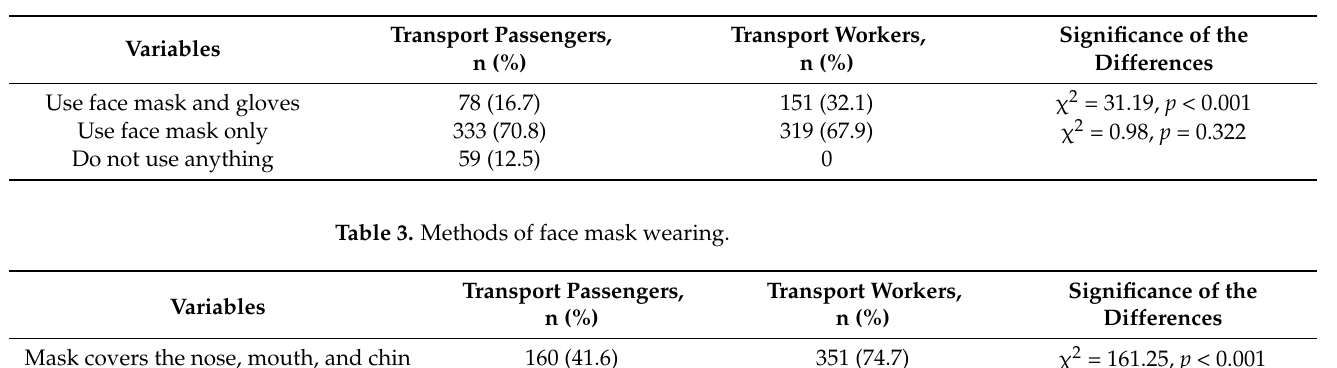
Table 2. Use of face mask and gloves.